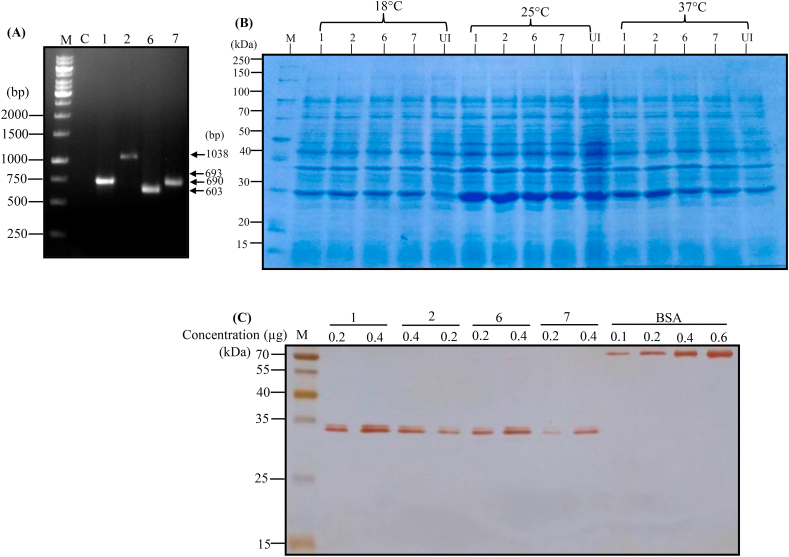
Cloning, expression, and affinity purification of four chimeric constructs in E. coli. A) Confirmation of recombinant clones using PCR. Construct 1 (expected gene size 693 bp); Construct 2 (expected gene size 837 bp with 201 bp from vector sequence due to use of T7 forward primer), Construct 6 (expected gene size 603 bp) and Construct 7 (expected gene size 690 bp) were synthesized and cloned into champion pET directional TOPO expression vector (pET100/D-TOPO). C: Negative control without template DNA; M: GeneRuler 1 kb DNA ladder (SM0311, Thermo Scientific). B) SDS-PAGE analysis showing the expression of recombinant chimeric proteins induced with IPTG (200 μM) at 18 °C, 25 °C and 37 °C induction temperature. Construct 1 (expected size 28.9 kDa including tag); Construct 2 (expected size 34 kDa including tag); Construct 6 (expected size 28.9 kDa including tag); Construct 7 (expected size 34 kDa including tag); UI: uninduced E. coli whole cell lysates C) Silver stained-SDS-PAGE gel electrophoresis showing the purity of multi-epitope antigens. Different concentrations of BSA were loaded to determine the approximate concentration of purified proteins estimated using Bradford assay. M: Prestained protein ladder (Cat. 26616, ThermoScientific). See fig. S5 for full, uncropped image.